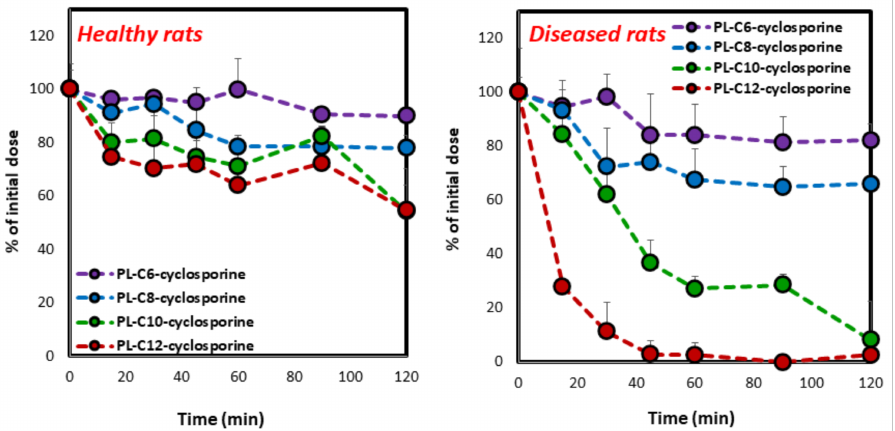
Figure 5. Activation of the four PL–cyclosporine prodrugs following incubation with healthy ( left ) vs. diseased ( right) cBBMVs. Average ± SD; n = 4. PL, phospholipid; cBBMV, colonic brush border membrane